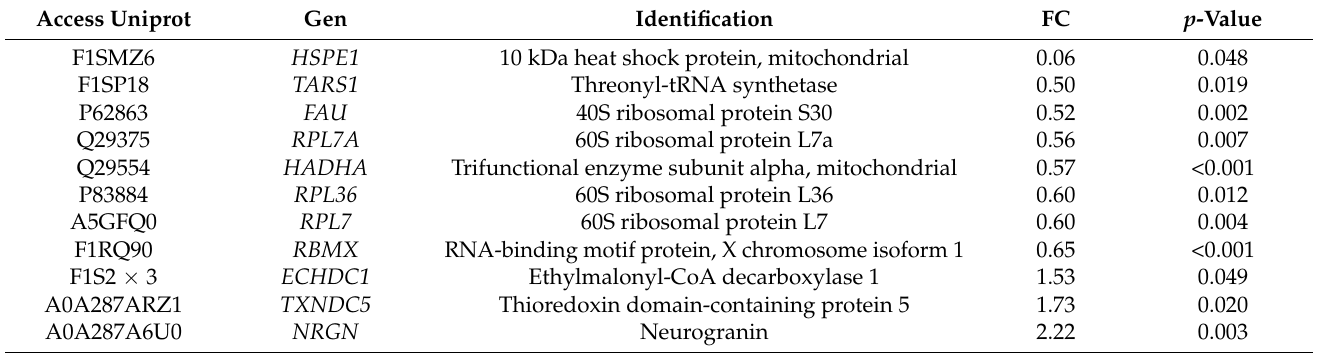
Table 2. Differentially abundant proteins between the Ctrl and HTX groups identified after TMT10- plex labelling. FC > 1.00 refers to an increase in HTX, and FC < 1.00 refers to a decrease in HTX.